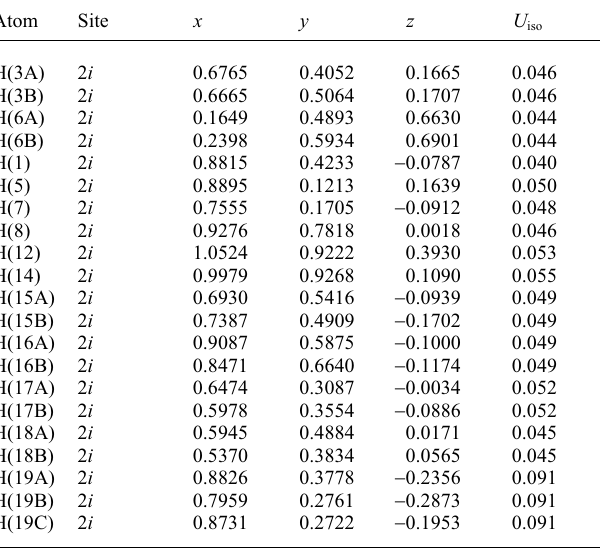
Table 3. Atomic coordinates and displacement parameters (in Å 2 )